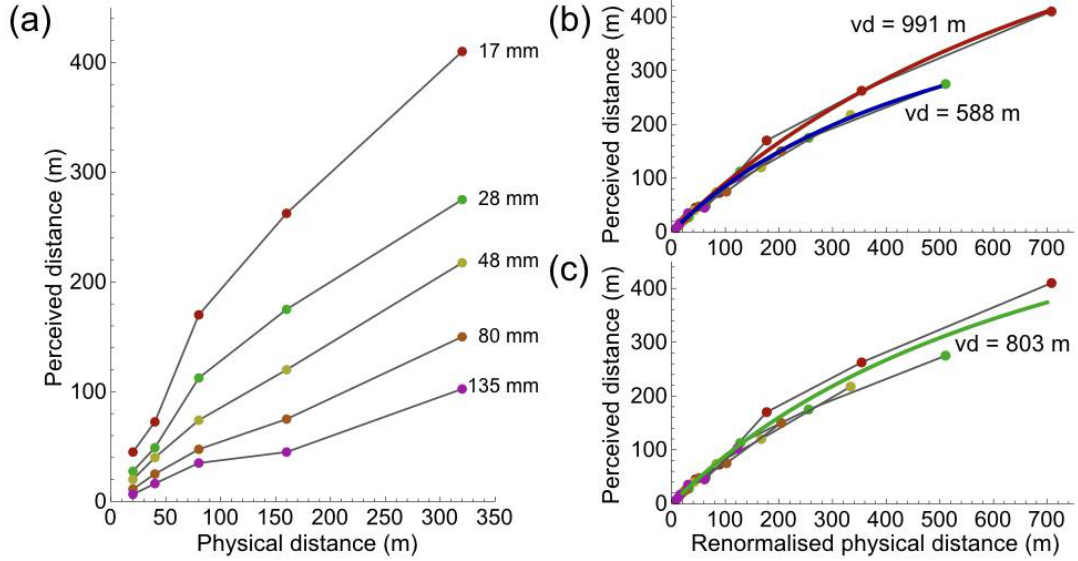
Figure 10. Perceived distance in pictures. ( a ) Data copied from Kraft and Green (1989). ( b ) Data of ( a ) with physical distances renormalized to the FoV of a FL 50 mm lens. Separate fits were computed for perspective distance curves for the 17 mm data (red) and the other data (blue). ( c ) Data of ( b ) fitted with a single perspective distance curve (green).